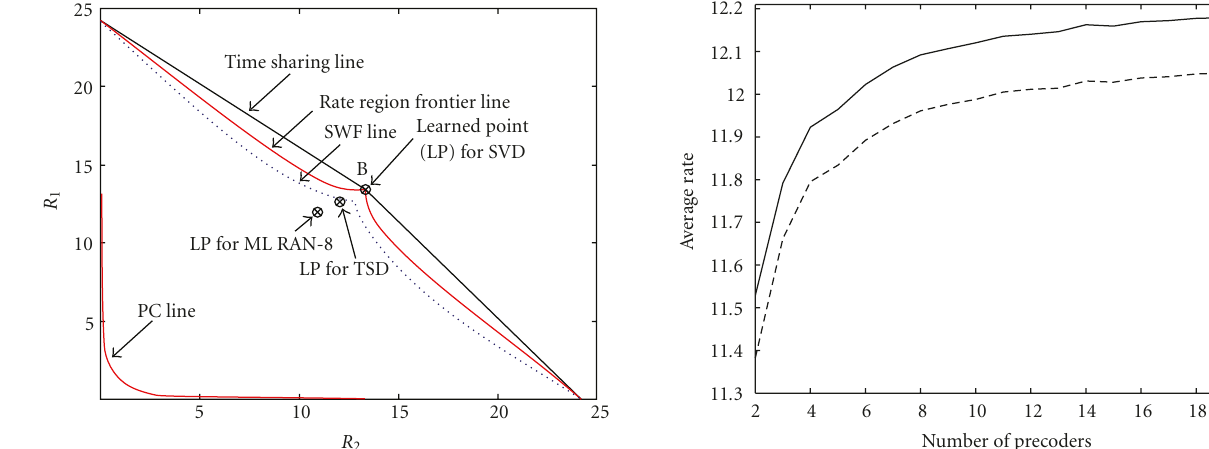
Figure 12: SVD-MIMO rate region—channel case 1.